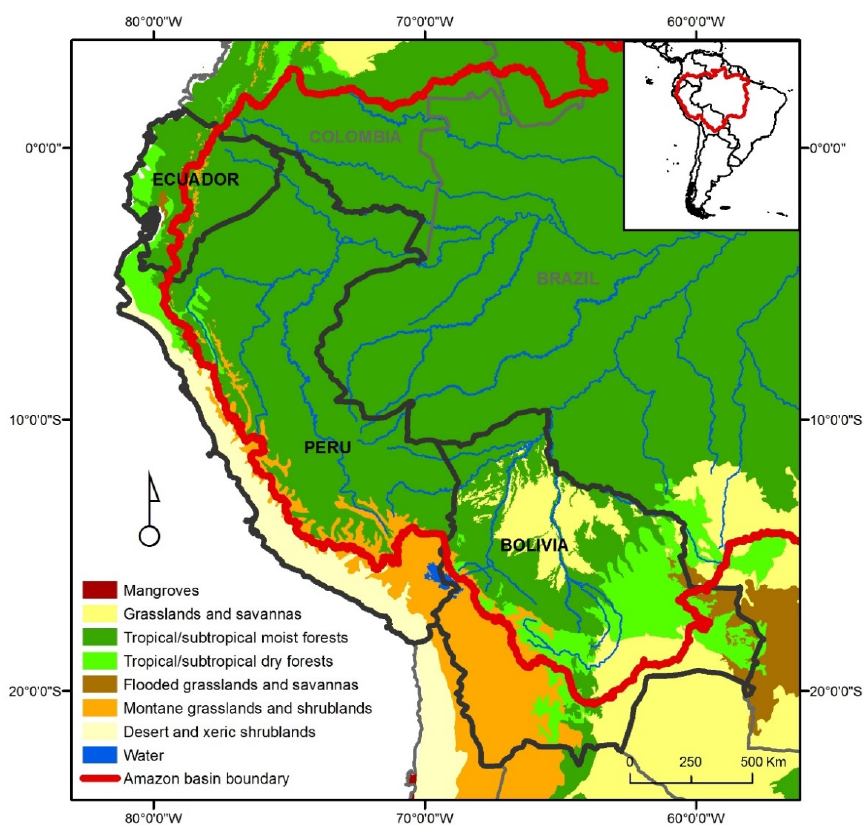
Figure 1. Biomes in Bolivia, Ecuador and Peru. Source: Authors’ mapping of data from WWF Ecoregions profile [8].